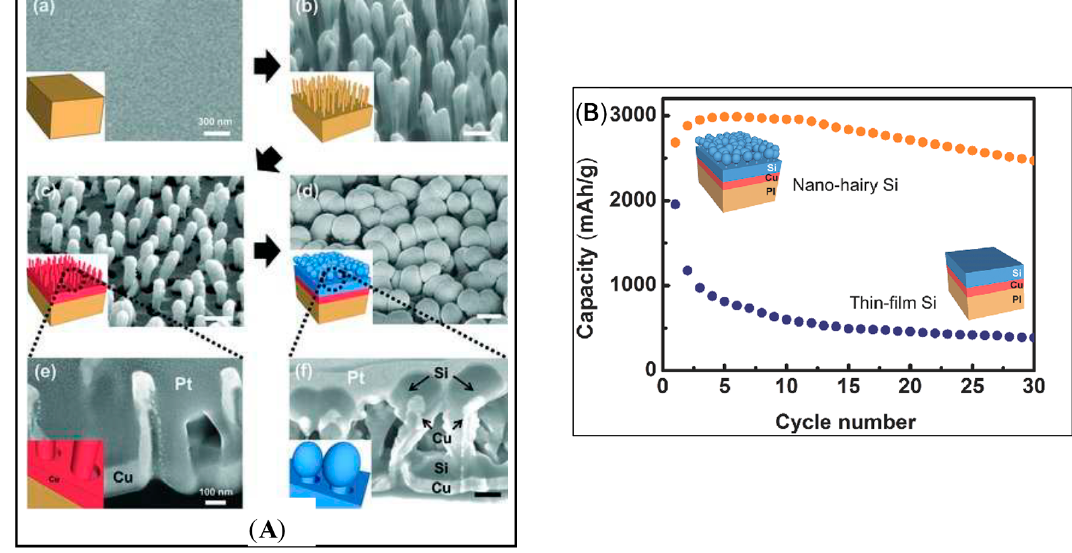
Figure 5. Plasma in energy applications. ( A ) Direct integration of nano-hairy Si anode on a nanorod array polymer substrate: (a) pristine PI substrate before CF 4 etching; (b) well-arrayed PI nano-hairy structures after CF 4 PECVD etching on pristine PI; (c) Cu (200 nm) as the current collector deposited by thermal evaporation; and (d) Si deposited (300 nm) as the active material by thermal evaporation on the sample (c); (e) A cross section image of sample (c); and (f) a cross section image of sample (d), both prepared by FIB cutting after Pt coating; ( B ) Capacity on delithiation step of Si on pristine and nano-hairy PI tested using a half cell. Reprinted with permission from [109]. Copyright 2014 Wiley.